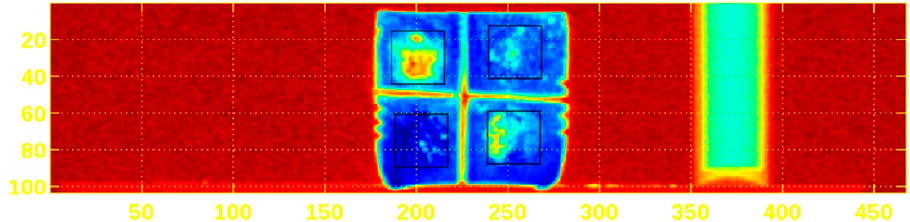
Figure 5. The occlusal view of Micro computerized calvaria after 8 weeks.